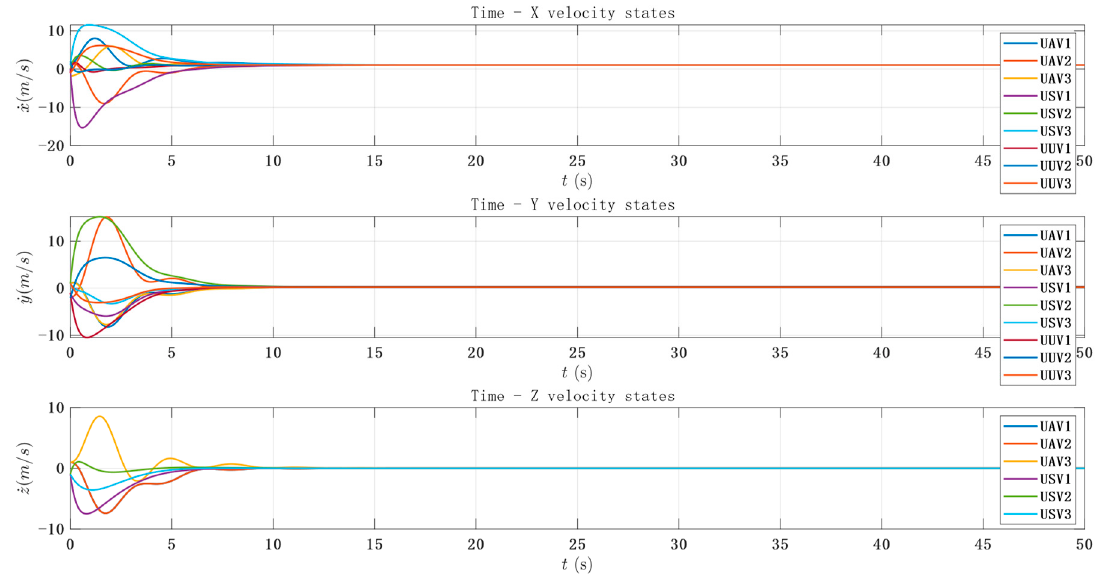
Figure 14. Velocity state with dynamic cooperative optimum formation control.